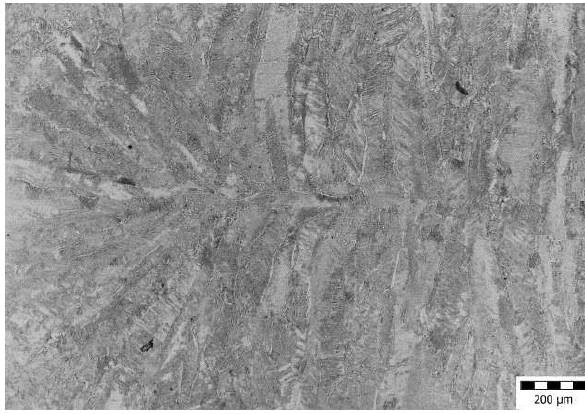
Figure 12: Microstructure of the weld nugget of sample E.